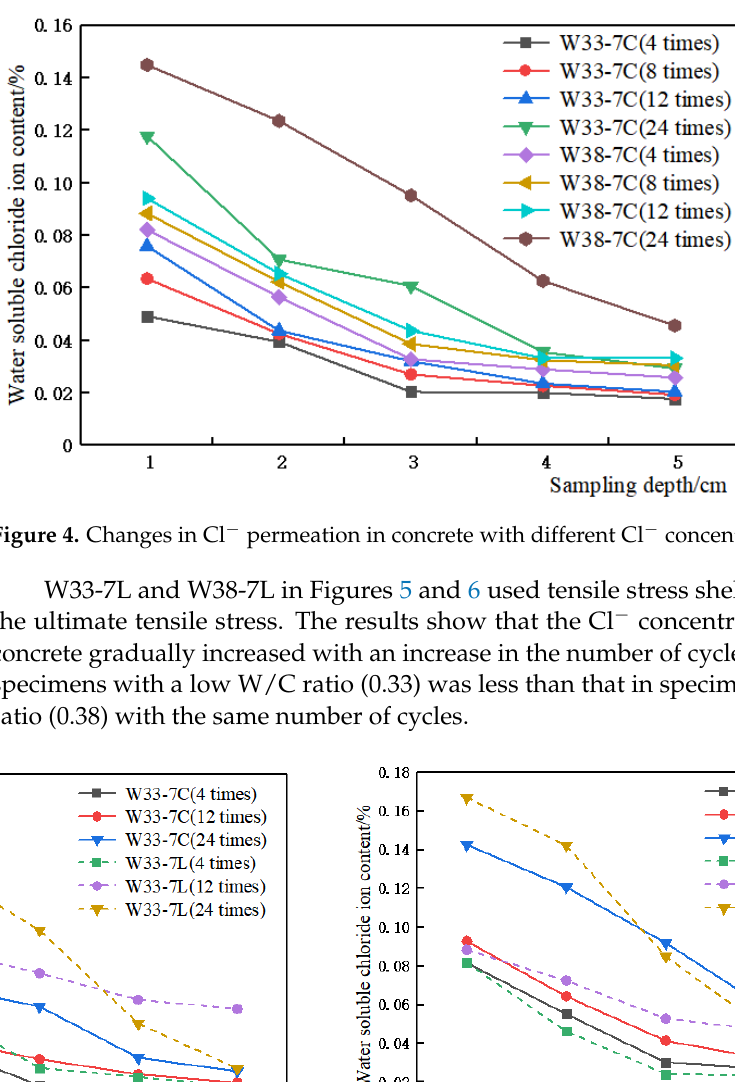
Figure 5. Comparison of ultimate bearing capacity in two models with different numbers of cycles: ( a ) W/C ratio of 0.33; ( b ) W/C ratio of 0.38.